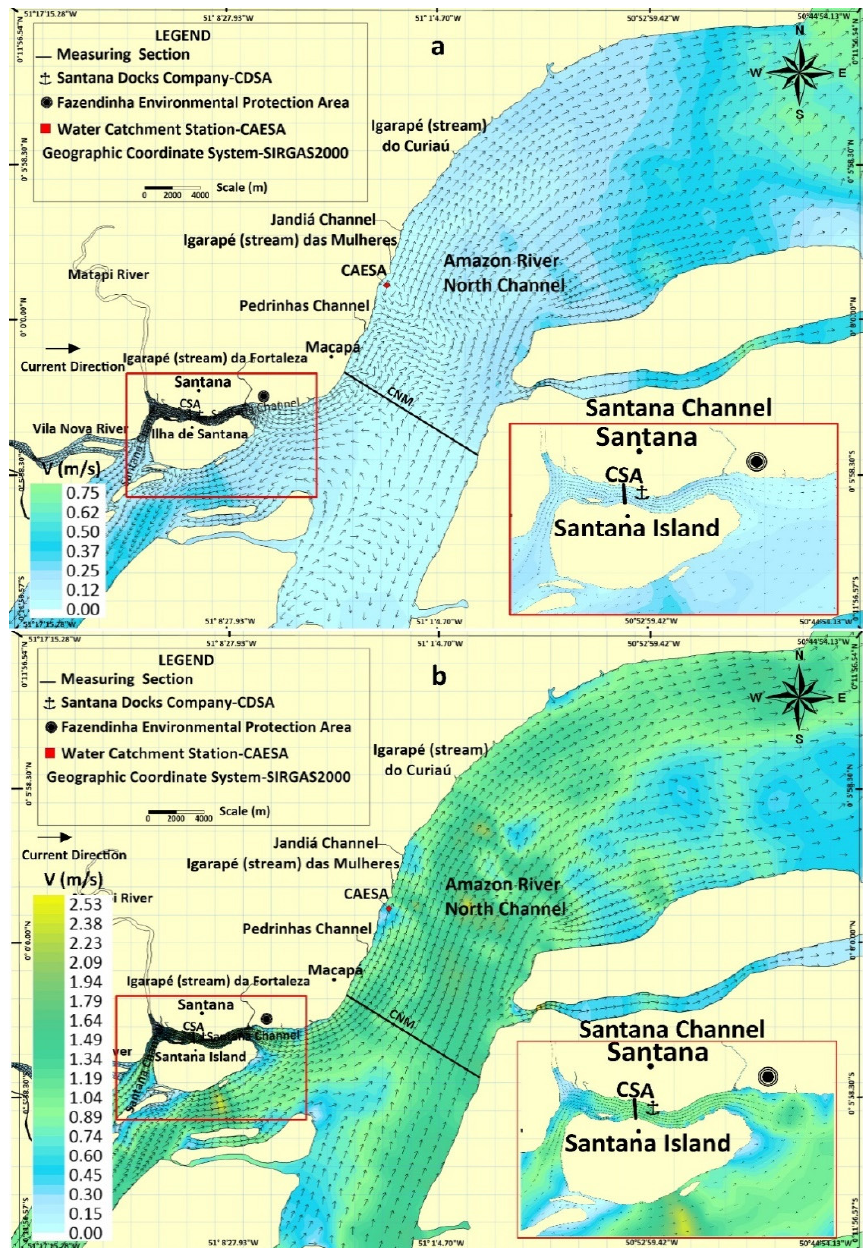
Figure 8. Spacial variation of the velocity field according to: ( a ) high-tide (18 March), with lower velocity intensity; ( b ) low tide (18 March), with higher velocity intensity. Geographic Coordinate System: Sirgas2000.